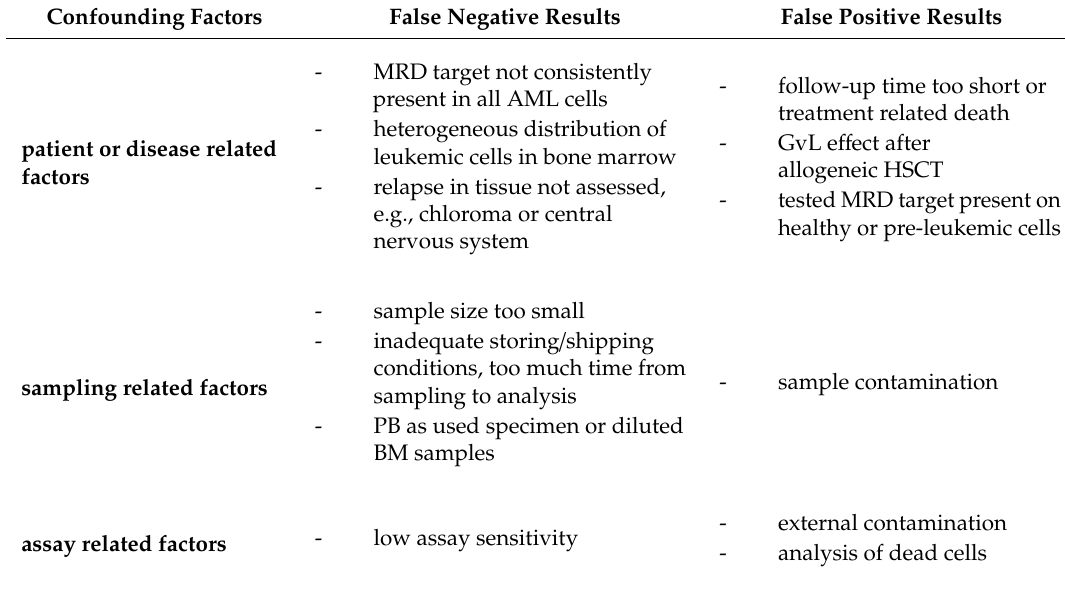
Table 1. Reasons for inadequate measurable residual disease test